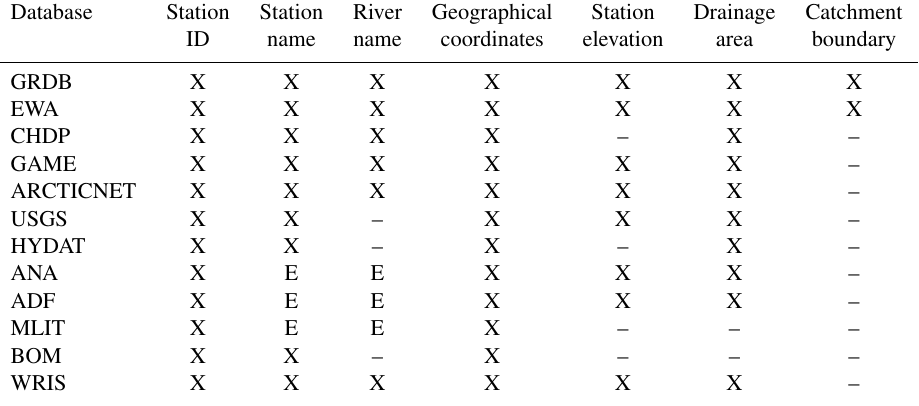
Table 3. Basic metadata available from data sources.